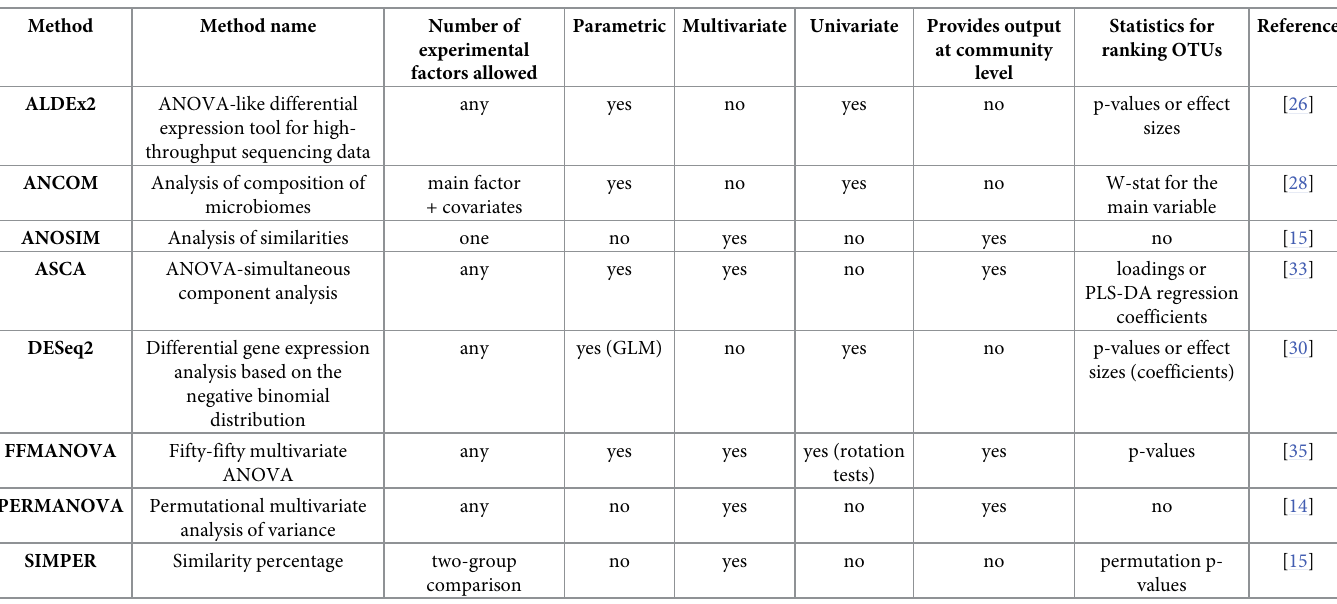
Table 1. An overview of statistical methods and their